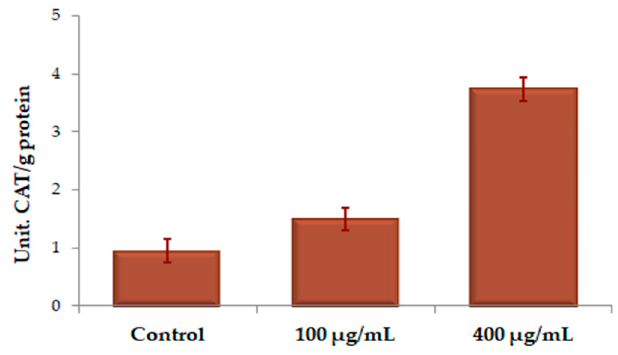
Figure 9. Assessment of CAT activity (U CAT / g protein) under action of di ff erent UBE concentrations on CAL 27 cells. The results represent the mean ± SE of the three independent experiments when comparing the e ff ects of UBE with the untreated control (t-test).